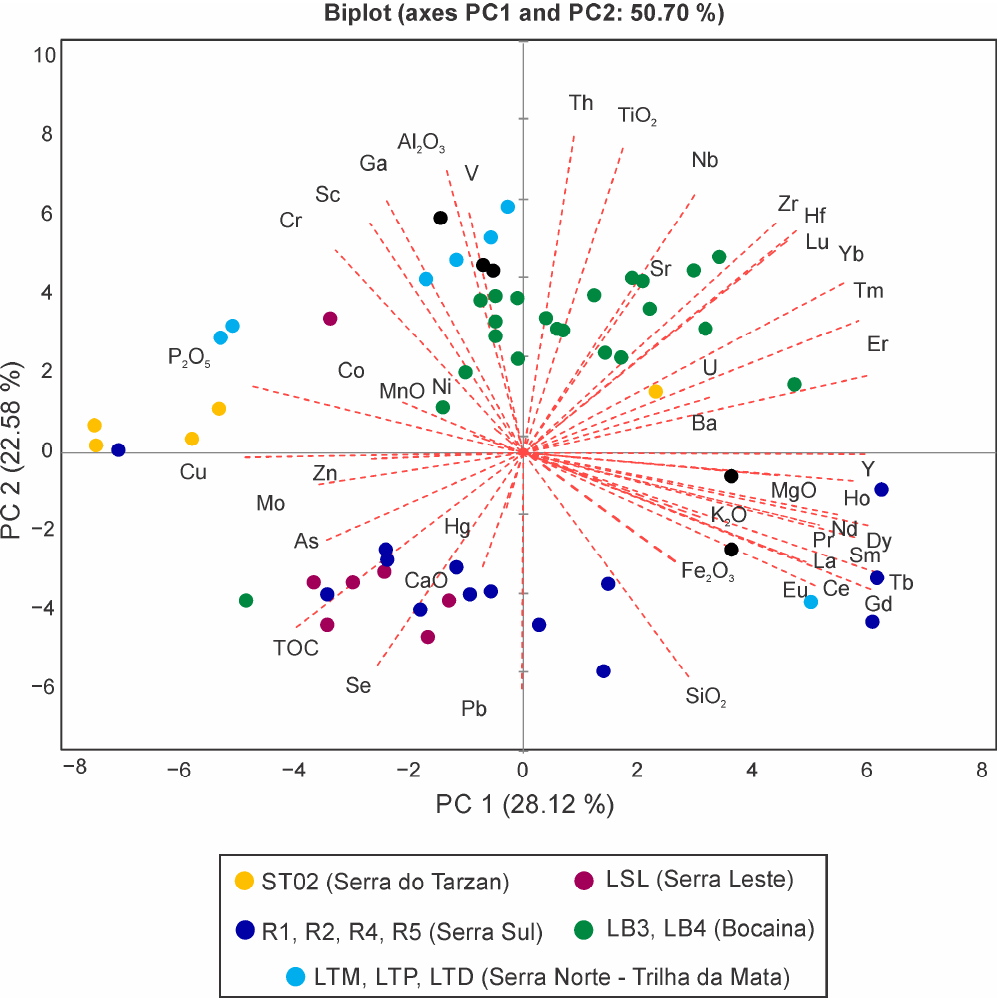
Figure 5. Principal component analysis (PCA) performed on centered log-ratio (clr)-transformed data for all filled lakes (sediment cores).